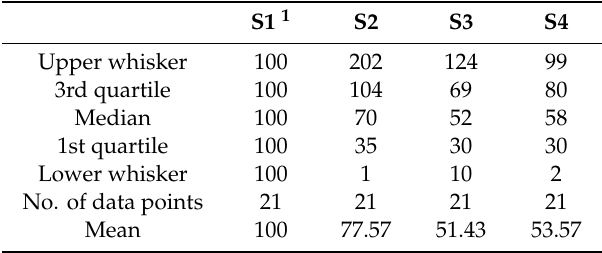
Figure 1. Boxplot presenting relative visibility values for 21 websites in snapshots. Table 3. Boxplot statistics for Figure 1.